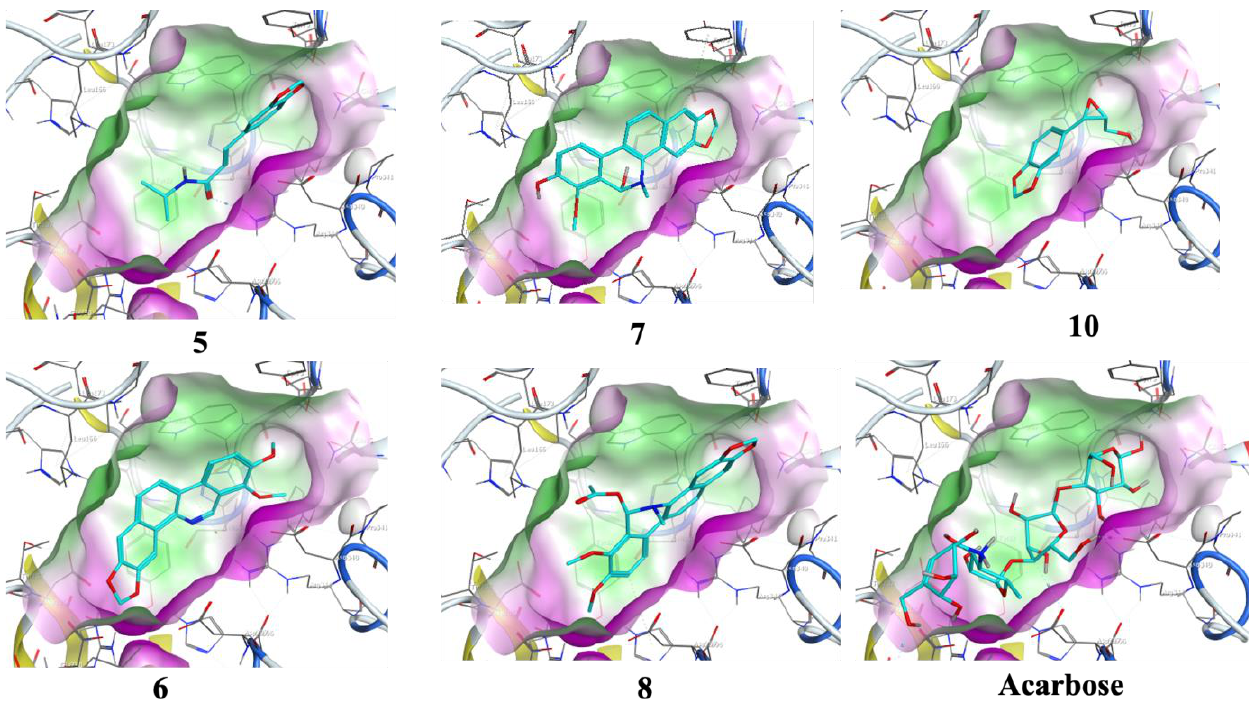
Figure 6. Docking conformation with the highest score conformers for Skimmianine ( 5 ), Norchel- erythrine ( 6 ), 6-Acetonyldihydrochelerythrine ( 7 ), and 6-Hydroxy-N-methyldecarine ( 8 ) alkaloids, 2,3-Epoxy-6,7-methylenedioxyconiferol ( 10 ), and the reference acarbose (carbon atoms in cyan) in the binding site of α -amylase (ID: 7TAA). Lipophilic areas on the molecular surface are colored green, while hydrophilic areas are colored purple.